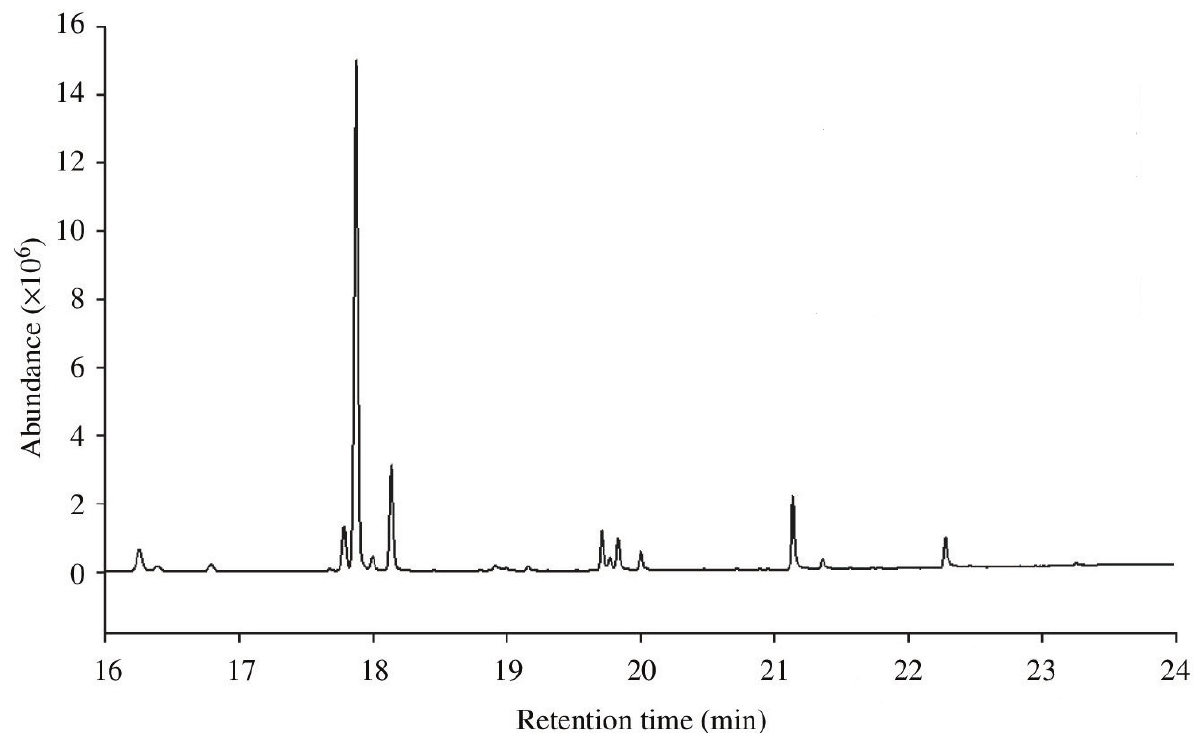
Figure 1. Example of a typical gas chromatograph output from a sample of Drosophila simulans CHCs. Each peak represents a different CHC component of the CHC profile, and the integrated peak area gives the abundance of that CHC in the sample. Smaller, relatively volatile CHCs have a lower retention time, and therefore appear first on the chromatograph, as they vaporize and are separated more quickly than larger, more stable CHC